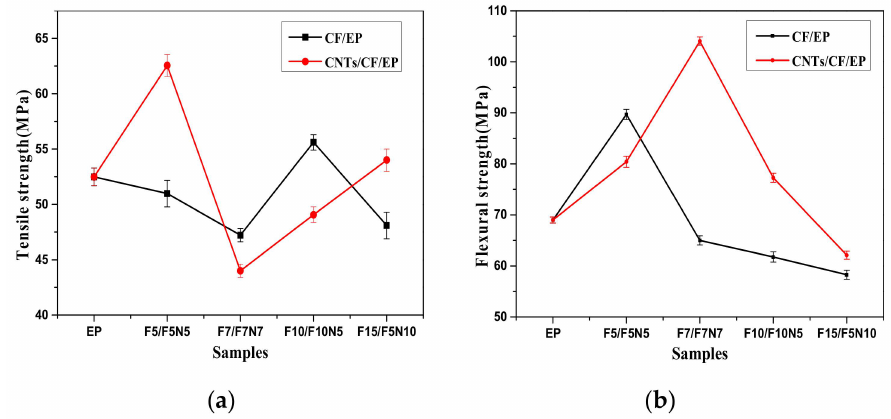
Figure 6. Tensile and Flexural strength of samples. ( a ): Tensile strength ( b ): Flexural